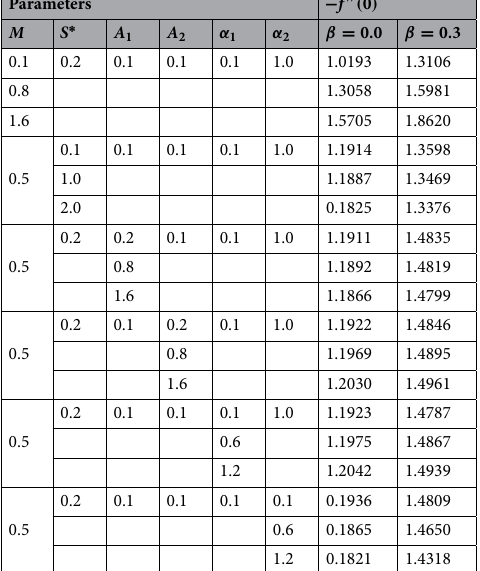
Table 2. Outcomes of − f ′′ ( 0 ) versus M , S ∗ , A 1 , A 2 , α 1 and α 2 .